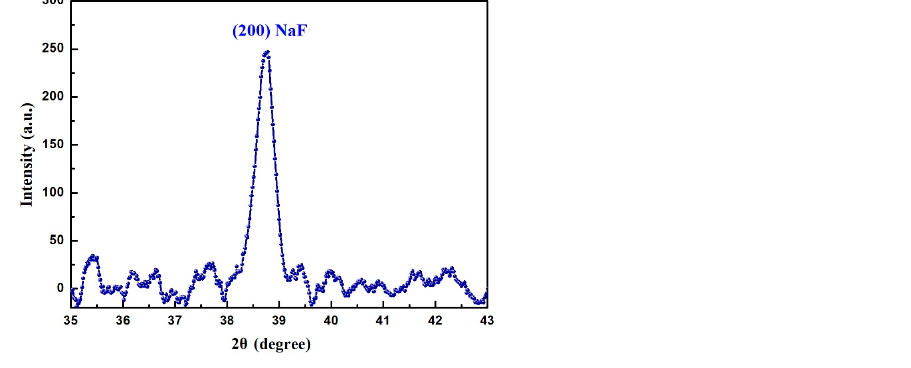
Figure 8. XRD pattern of the PTR glass after fs laser exposure and HT showing the onset of crys- tallization .